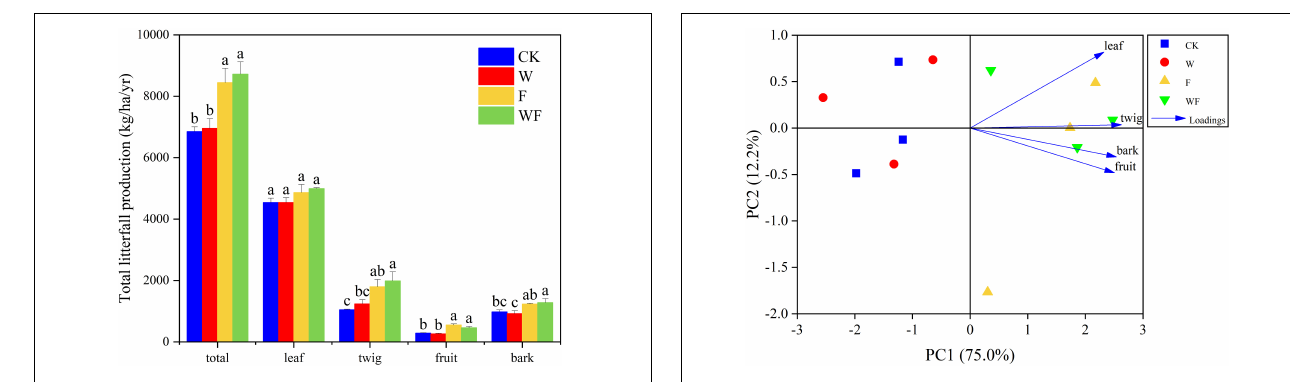
Figure 3 | Principal component analysis (PCA) of annual litterfall production (leaf, twig, fruit, and bark) under different treatments. Nutrients